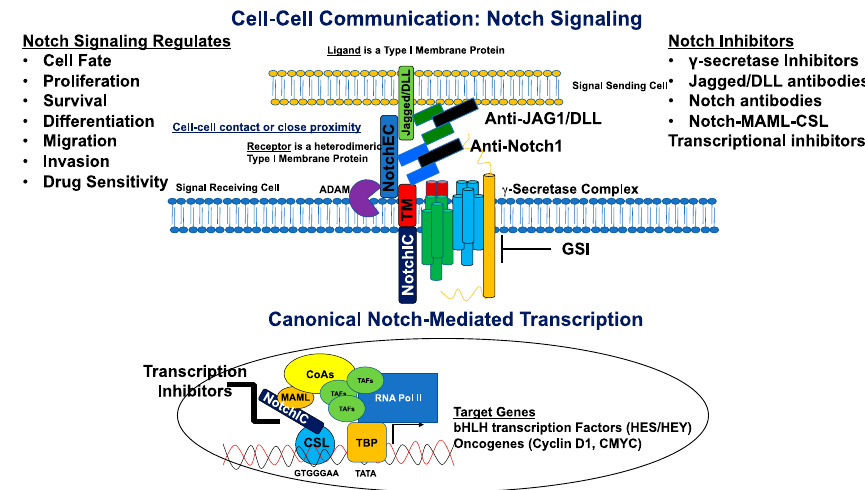
Figure 2. Canonical Notch signaling and inhibitors. The signal-sending cell expressing a Notch ligand (Jagged/DLL) is in close proximity to the signal-receiving cell expressing a Notch receptor. The ligand binds the Notch receptor through EGF-like repeats, and this interaction dislodges the extracellular portion of Notch (NotchEC) from the transmembrane portion (NotchIC-TM). NotchEC is endocytosed with the ligand into the signal sending cell. The removal of NotchEC exposes the ADAM cleavage site on the ecto-domain of the NotchIC-TM. ADAM-mediated cleavage creates a substrate (NEXT: Notch extracellular truncation) for the γ -secretase complex. This subsequent cleavage produces a product (NotchIC) that translocates to the nucleus. NotchIC binds to CSL and recruits MAML. MAML recruits other transcriptional co-activators and the RNA POL II initiation machinery to initiate transcription of Notch target genes including basic helix loop helix (bHLH) proteins of the HES and HEY family of transcriptional repressors. Other genes include the oncogenes, CMYC and CCND1 (Cyclin D1) for initiation of the cell cycle. Notch signaling is inhibited by a variety of molecules that include γ -secretase inhibitors (GSIs), antibodies directed against Notch ligands and receptors, and transcriptional inhibitors that target the NotchIC-MAML-CSL ternary complex. Notch regulates cell fate, proliferation, survival, di ff erentiation, migration, invasion, and sensitivity to cancer